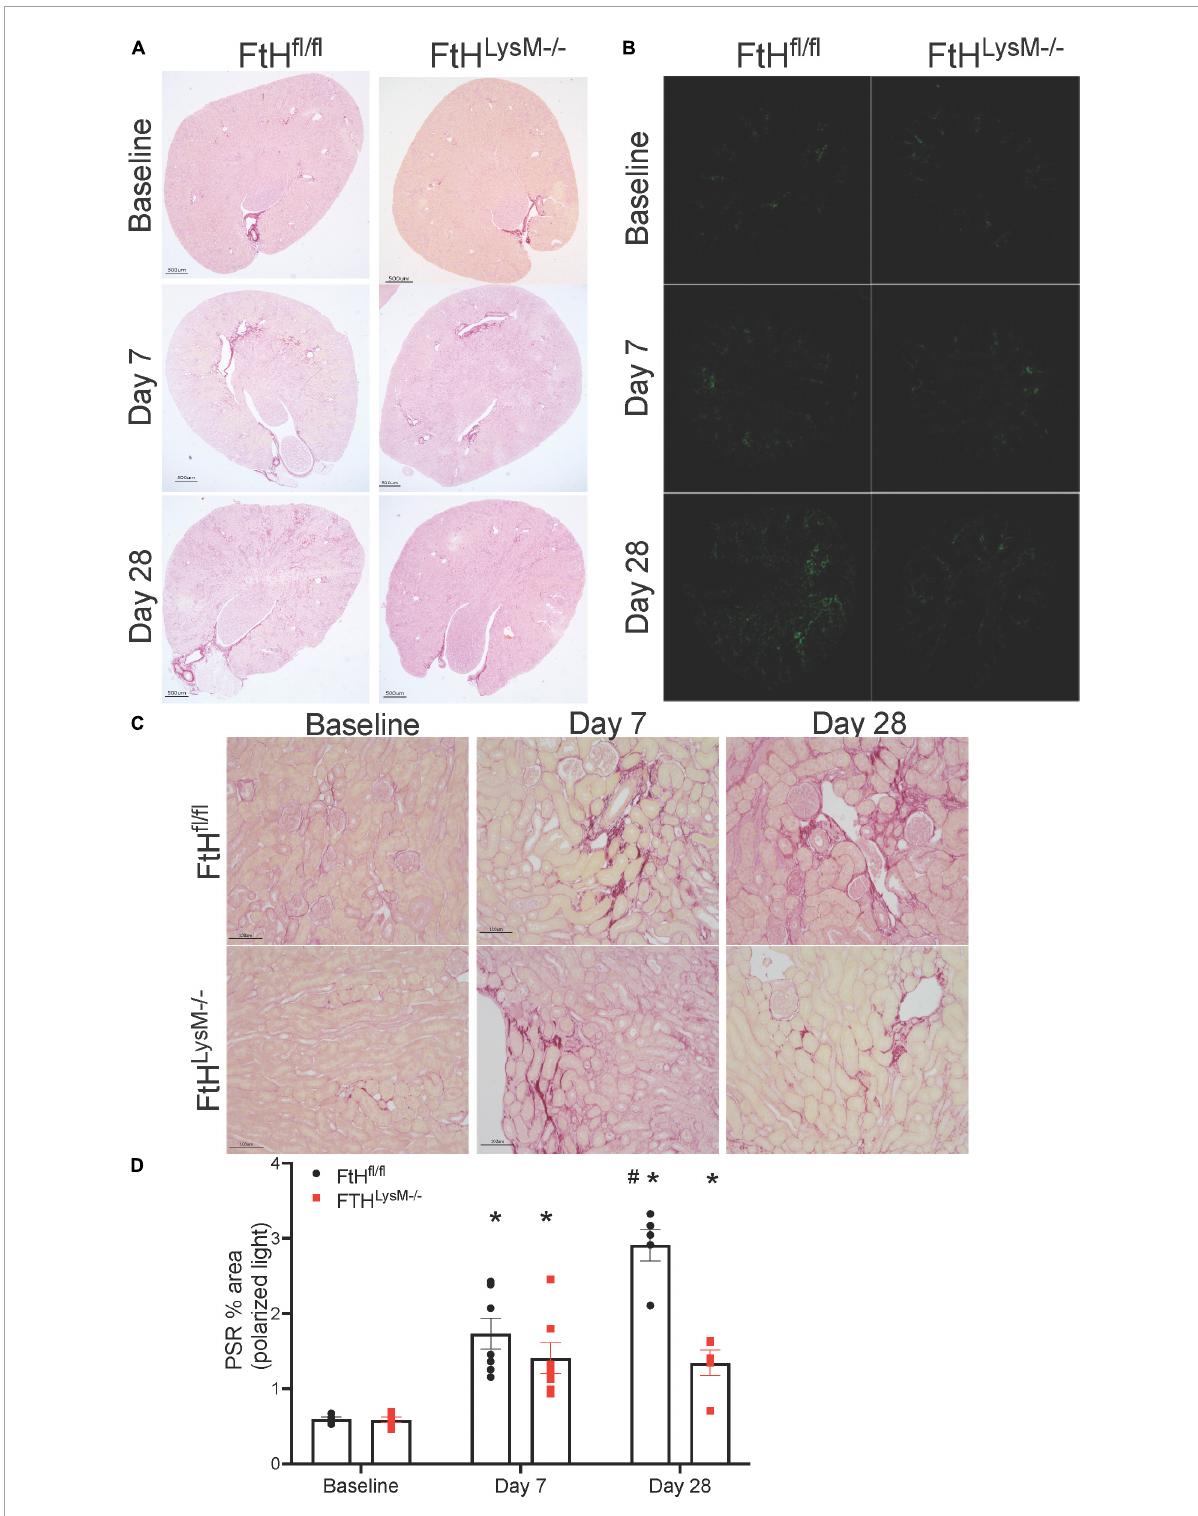
FIGURE5 Myeloid FtH deficiency is associated with reduced fibrosis. Picrosirius staining was performed on the kidney sections to determine fibrosis following injury. (A,B) Representative images of the stained kidney sections are shown. Scale bar represents 500 µ m in the upper panels and 100 µ m in the lower panels. (C) Representative images of the stained kidney sections under polarized light are shown. (D) Collagen deposition was quantified under polarized light and data are expressed as percent area. # p < 0.05 vs. FtH fl / fl